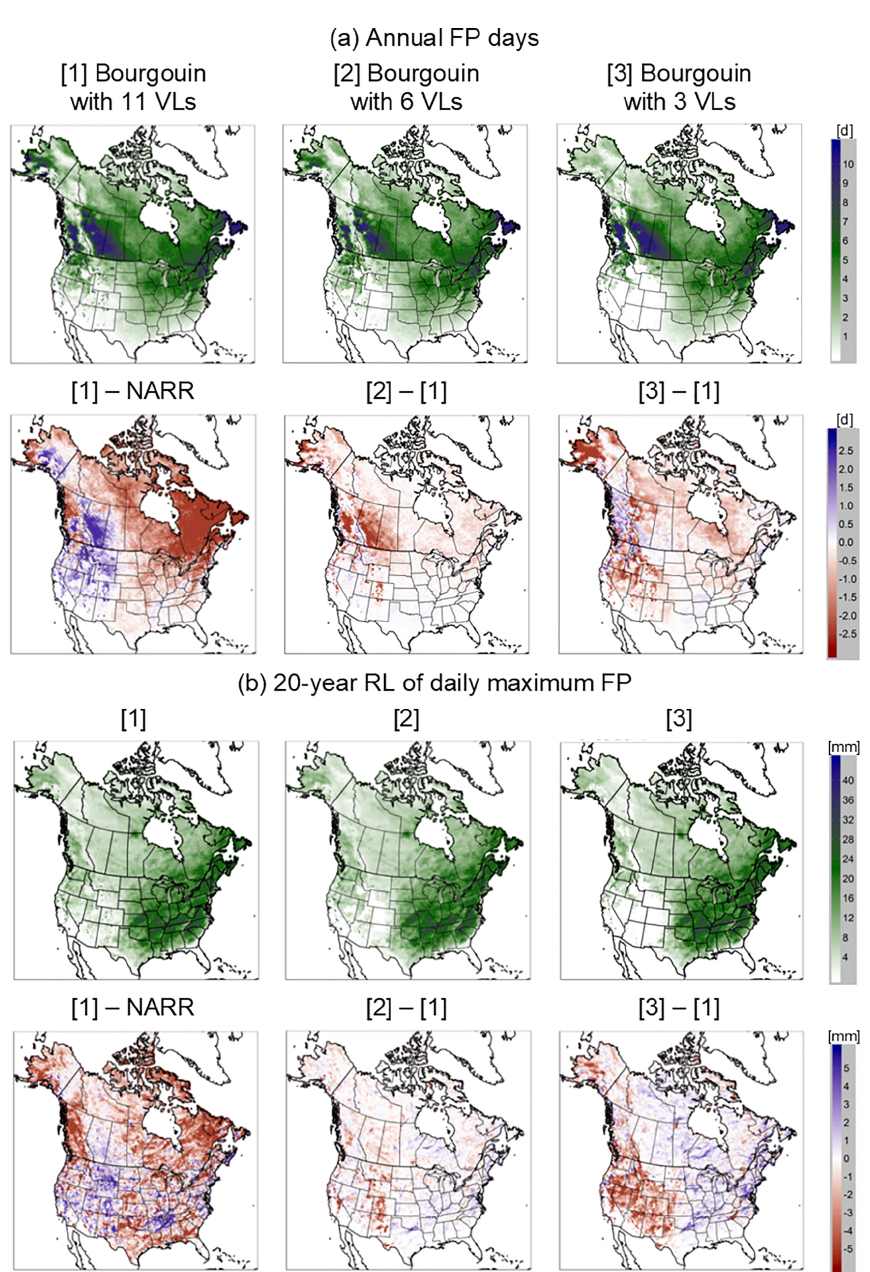
Figure 2. Annual freezing-precipitation (FP) days and 20-year RL of daily maximum FP obtained by the offline Bourgouin algorithm with 11 (200, 300, 400, 500, 600, 700, 800, 850, 900, 950 and 1000hPa; case 1), 6 (200, 400, 600, 800, 900 and 1000hPa; case 2) and 3 (500, 850 and 1000hPa; case 3) vertical levels (VLs) of NARR output for the baseline period. The last case has identical VLs to CanRCM4. The two statistics from NARR (with online NCEP algorithm) are presented in Fig. 1. Differences between NARR and case (1), cases (1) and (2), and cases (1) and (3) are also